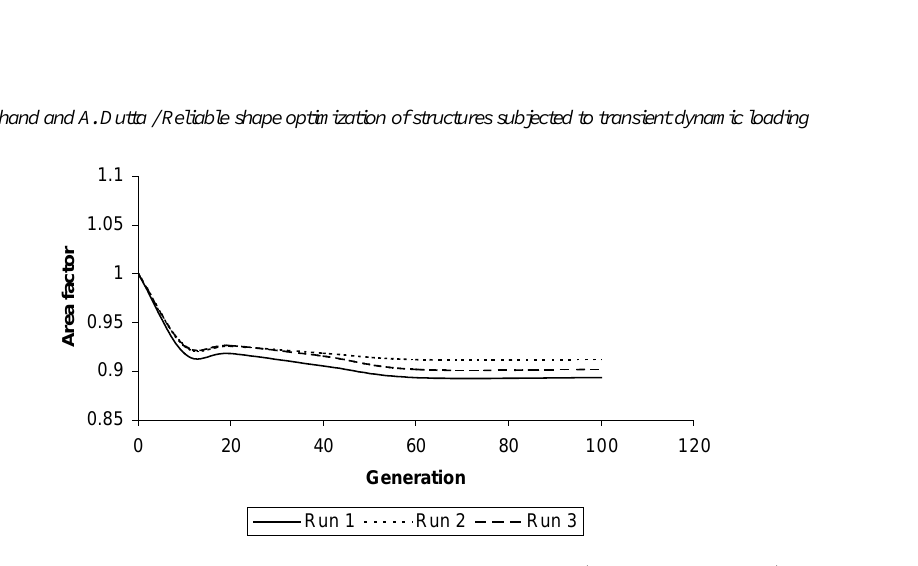
Fig. 19. Genetic evolution of area factor with varying genetic parameters (simply supported